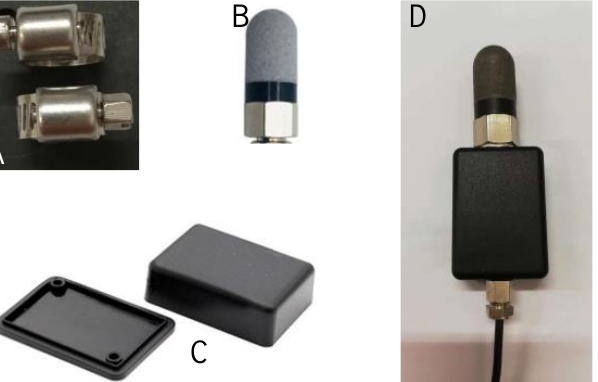
Figure 5. A schematic diagram of the overall hardware circuit system. The BVIC sensor mechanical structure contains a bimetallic ring measuring probe, a temperature probe, a waterproof protective cover and sensor housing, and a ring measuring probe, as shown in Figure 6a. It is made of ASTM 304 stainless steel. The width is 12.6 mm and the thickness is 0.65 mm. Through the adjustment knob on the electrode, the diameter of the ring electrode is adjustable in a range from 10 to 40 mm, the corresponding surface coverage areas ranged from 791.28 mm 2 to 3165.12 mm 2 (the surface coverage area is as in Formula (11)), so that it can adapt to different diameters of the branches. The waterproof protective cover of the temperature probe, with a length of 45 mm and an outer diameter of 16.7 mm, is shown in Figure 6b. The BVIC sensor housing is made of 3D printing resin material, with a printing tolerance of 0.2% and outer dimensions (length × width × height) of 51 mm × 36 mm × 20 mm, as shown in Figure 6c. The assembled BVIC sensor is shown in Figure 6d. where S is the surface coverage area; R branch is the diameter of the ring electrode; and h is the width of ring electrode.